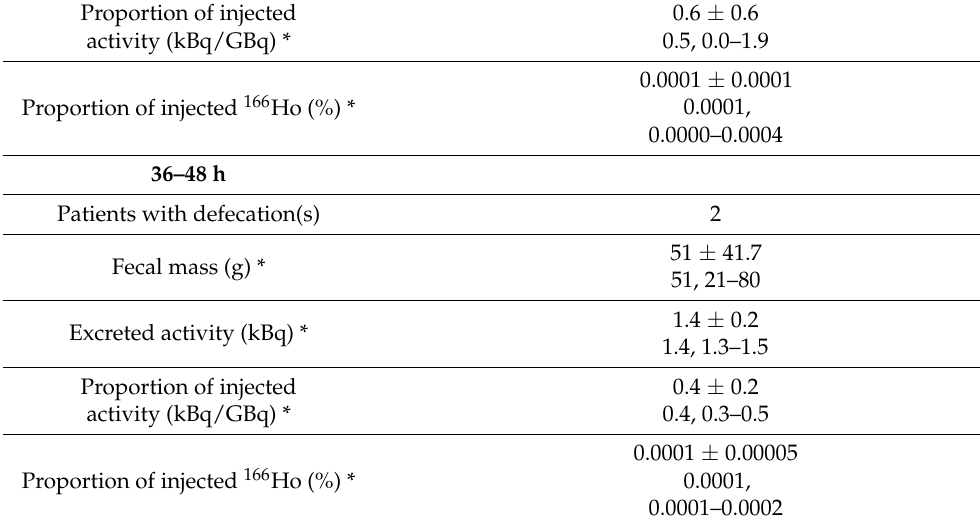
Figure 7. Correlation between effective half-life and excreted activity of 166 Ho after TARE planning (24 h) and TARE treatment (48 h) procedures.